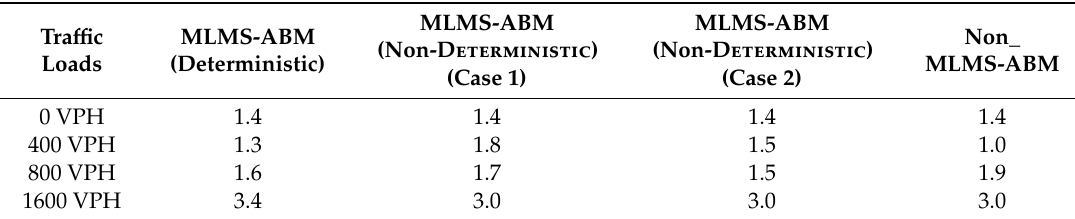
Table 4. Comparing the average vehicle speed for the hypothetical road network and the I-25 road